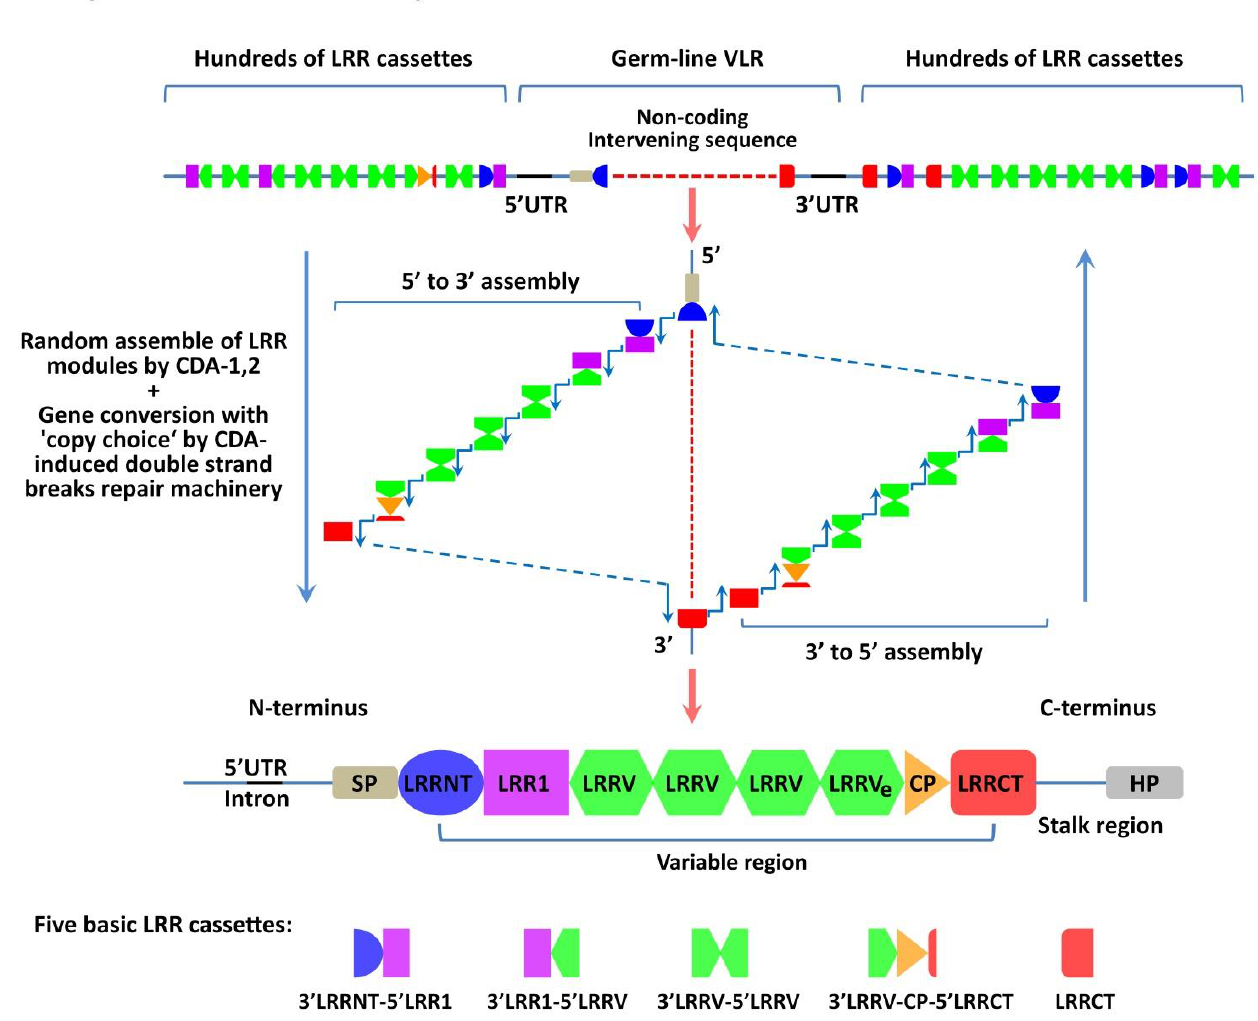
Figure 1. Diversification mechanism of variable lymphocyte receptors in jawless vertebrates. The germ-line VLR gene is incomplete and includes a non-coding intervening sequence flanked by hundreds of partial LRR gene cassettes. So, there are no direct coding sequences for the LRRNT, LRR1, LRRVs, LRRVe, and LLRCT modules in the germ-line configuration of the VLR genes. The assembling of functional VLR occurs during lymphocytes maturation in the thymoid by random and sequential copying of sequences from the flanking LRR cassettes into the non-coding intervening sequence in the direction from the 5’ LRRNT or from the 3’ LRRCT end. Diversification of the VLR repertoire mediates by CDA action and occurs because of the gene conversion-like process with nonreciprocal insertion of LRR cassettes into the germ-line VLR gene, and the “copy choice” mechanism, which includes an original template switch to a donor sequence of another LRR module during replication. This process is presumed to be directed by the short homologous stretches of sequence between the original and donor LRR sequences. The general array of LRR cassettes can be classified into five main structural groups, shown at the bottom of the figure. The mature VLR gene consists of several coding sequences: SP, LRRNT, LRR1, two to eight modules LRRV, LRRVe, CP, LRRCT, and the stalk region with an HP end, which anchors the VLR protein in the lymphocyte membrane. VLR, variable lymphocyte receptor; SP, signal peptide; LRR, leucine-rich repeat; LRRNT, N-terminal LRR-capping module; LRR1, first LRR; LRRV, variable LRR; LRRVe, end variable LRR; CP, connecting peptide; LRRCT, C-terminal LRR-capping module; HP, hydrophobic peptide; UTR, untranslated region; CDA, Cytidine deaminase. The illustration is not drawn to scale. It should be noted that VLR repertoires obtained from the thymoid and peripheral blood are different. First, the thymoids often contain non-functional assemblies of VLRs